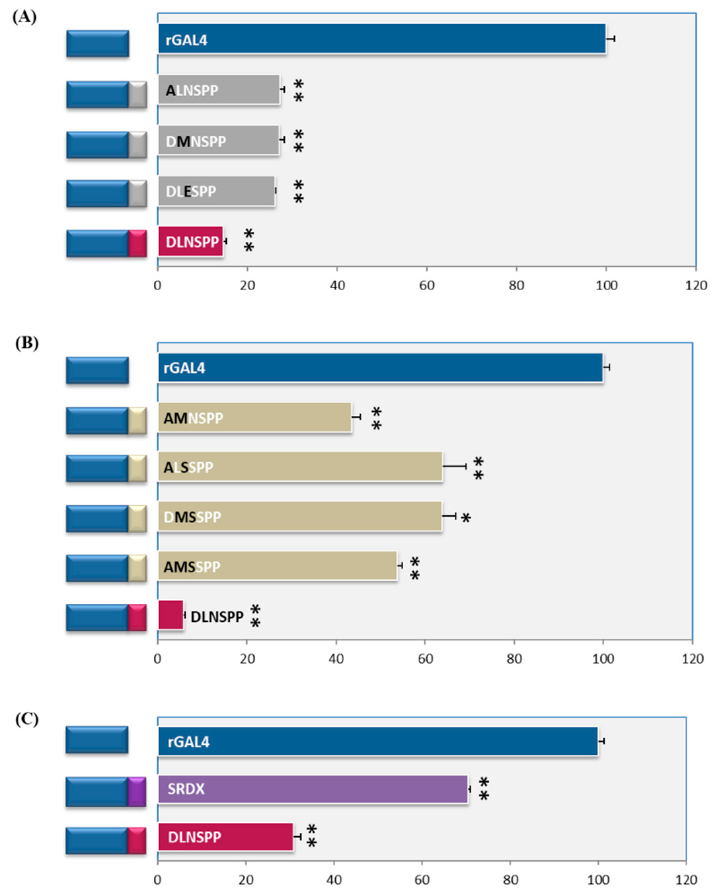
Figure 5. Mutation analysis of hexapeptide DLN144 motif (DLNSSP) and comparison with SRDX. The bar graphs show results of ONPG assay depicting β -galactosidase units on the x -axis, as a percentage of activation by rGAL4, for ( A ) single, ( B ) double, and triple mutations of DLN. All mutated residues are indicated in black; ( C ) comparison of the repressive abilities of SRDX from Arabidopsis and DLN144 motif from rice when fused with rGAL4 activator. In all figures, the pictorial representation of the fused protein is on the left side. rGAL4 is represented in blue color and the DLN hexapeptide in red color. Double and single asterisks represent p -values of ≤ 0.005 and ≤ 0.05 in biological triplicates. The standard error bars have been indicated on the bar graphs.